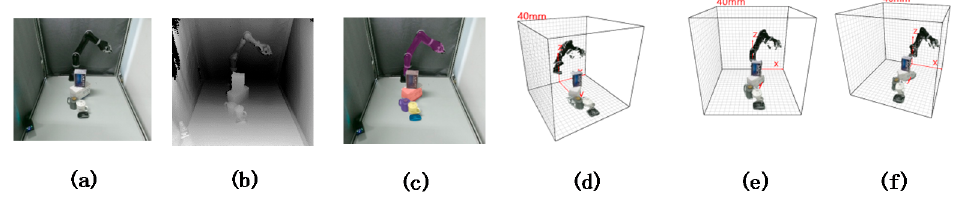
Figure 6. The experimental results of our method and other main methods on the YCB-Video dataset. ( a ) YCB-Video data RGB image; ( b ) ORB reconstruction results; ( c ) EKF-SLAM reconstruction results; and ( d ) OURS reconstruction results.